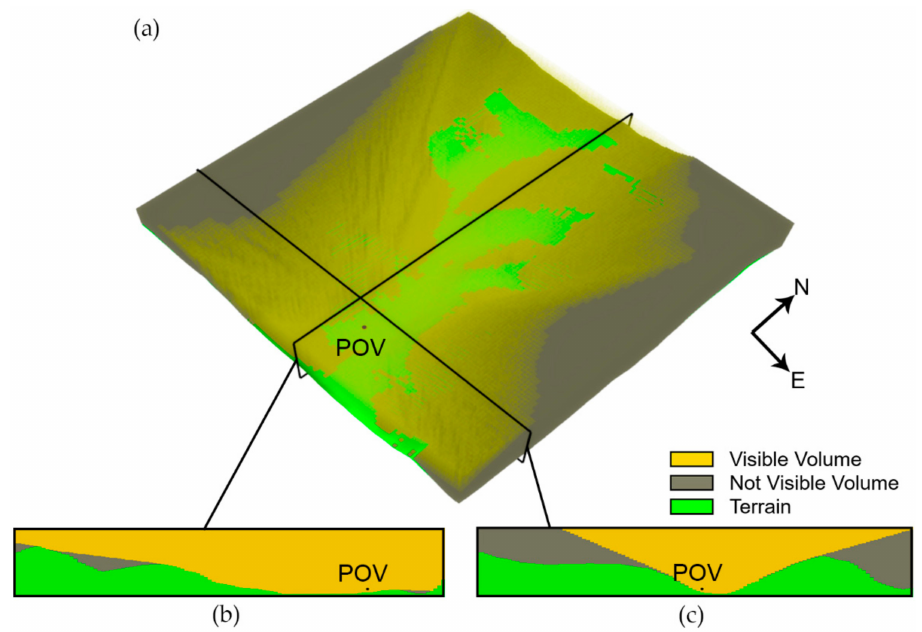
Figure 11. ( a ) 3D viewshed and ( b , c ) two vertical profiles through POV: ( b ) north–south visibility profile and ( c ) east–west visibility profile.